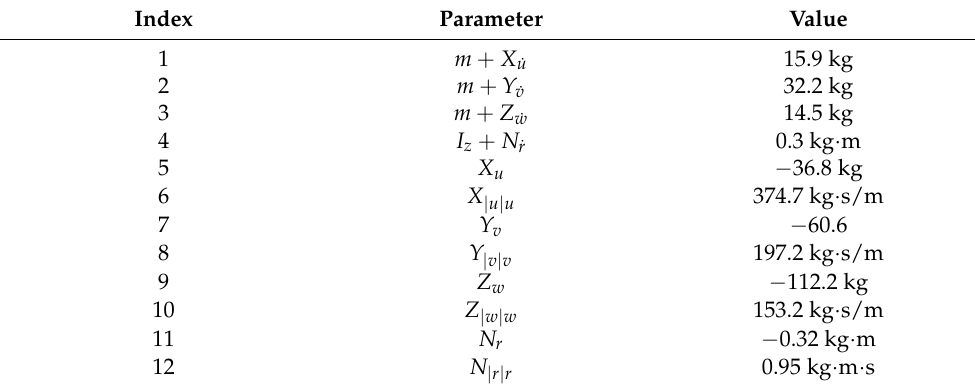
Table 1. Parameters of AUV models in numerical